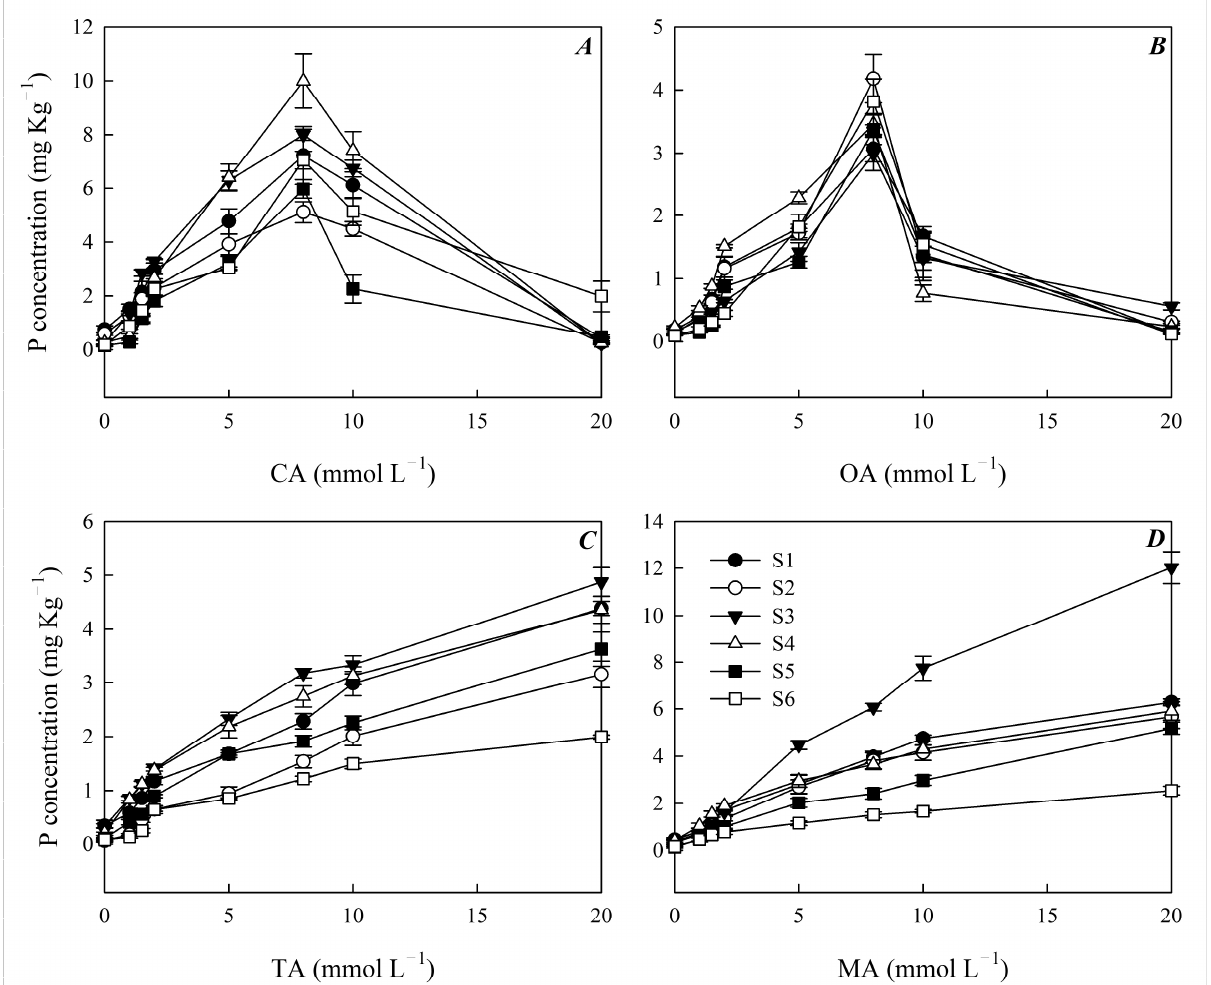
Figure 1. Influence of different concentrations of ( A ) CA, ( B ) OA, ( C ) MA and ( D ) TA on P release in soils. Note: CA is citric acid; OA is oxalic acid; TA is tartaric acid; MA is malic acid. S1, S2, S3, S4, S5 and S6 are six sampling areas.